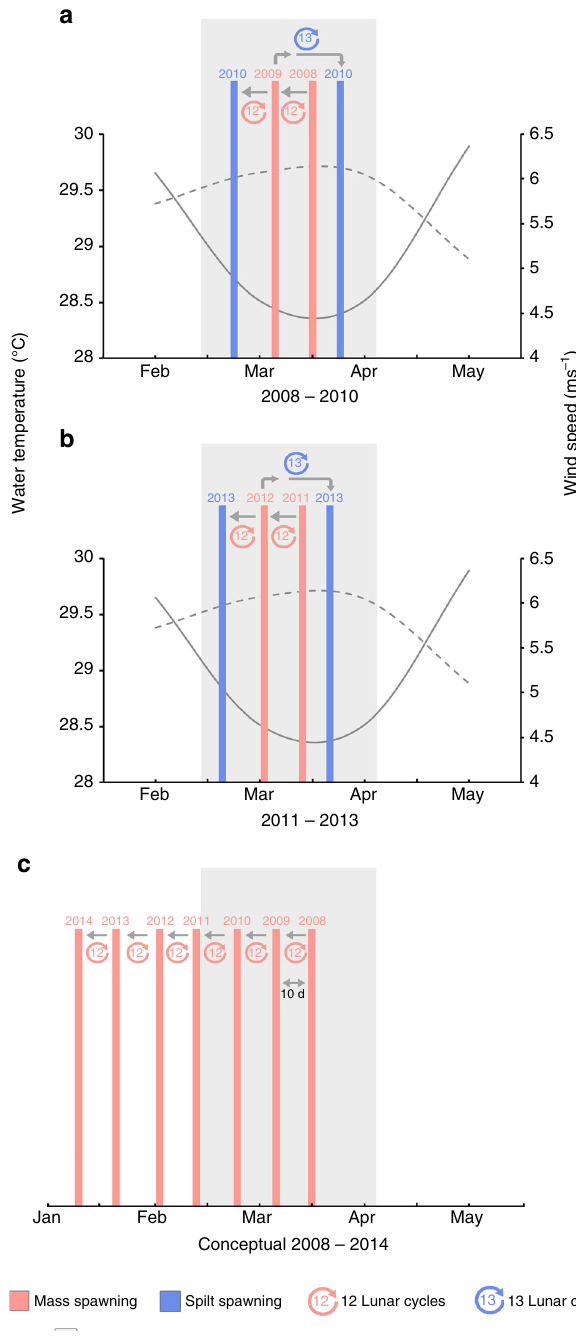
Fig. 2 Autumn spawning dates and lunar cycles in relation to the optimal environmental window. Mass spawning events are shown with pink bars and split spawning events are shown with blue bars. a , b The empirically observed autumn spawning realignment cycles that occurred due to split spawning in 2010 ( a ) and 2013 ( b ), maintaining spawning in the environmental window (warm water temperatures and low wind speeds). Water temperatures and wind speeds for Scott Reef are the mean monthly values obtained from the Hadley Centre Sea Surface Temperature data set from 1990 to 2000 and the NOAA Earth Systems Research Laboratory from 1968 to 1996 respectively. c The hypothetical shift in the spawning date, out of the optimal environmental window, if spawning occurred every 12 lunar months without realignment. For example, if spawning occurred on the 30th of March in 2008 (far right pink bar) and then successively every 12 lunar months, then the spawning date would shift earlier by ~10 days each year (grey arrows), occurring on the 24th of January in